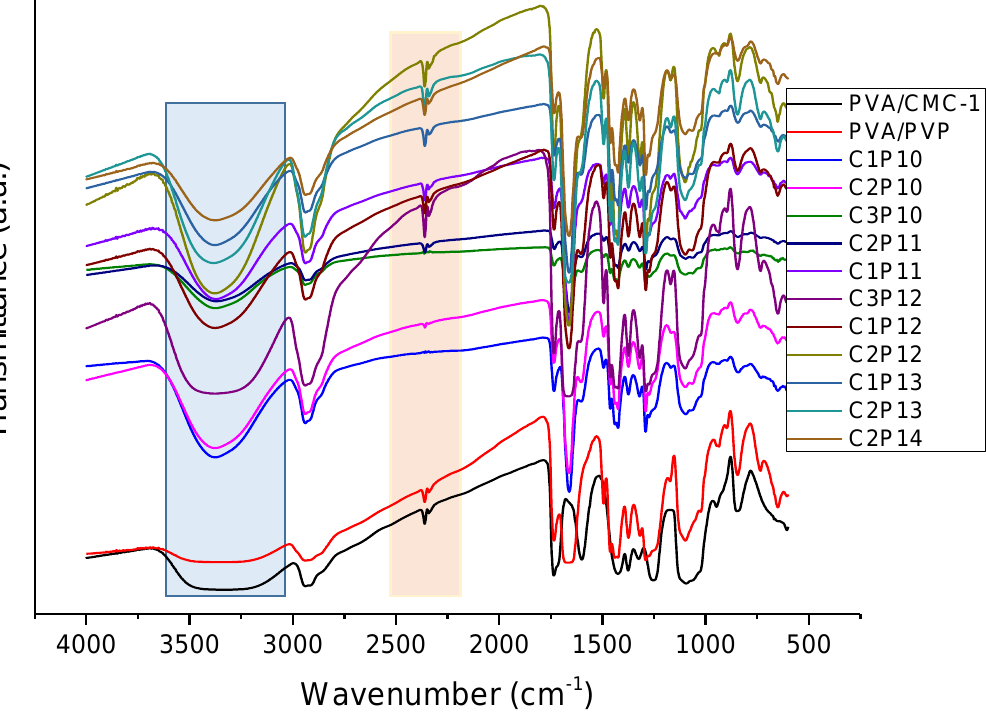
Figure 1. FTIR-ATR spectra of polyvinyl alcohol (PVA)/polyvinylpyrrolidone (PVP)/carboxymethyl cellulose (CMC) composite nanofibers with varying weight ratios of PVP and CMC.